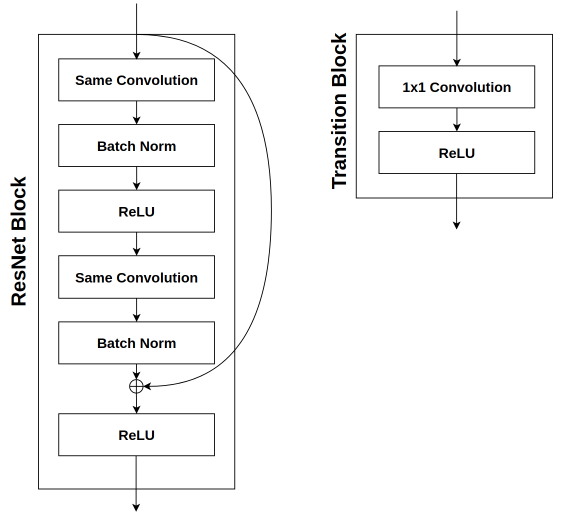
Figure 3. The structures of a ResNet block ( left ) and a transition block ( right ).